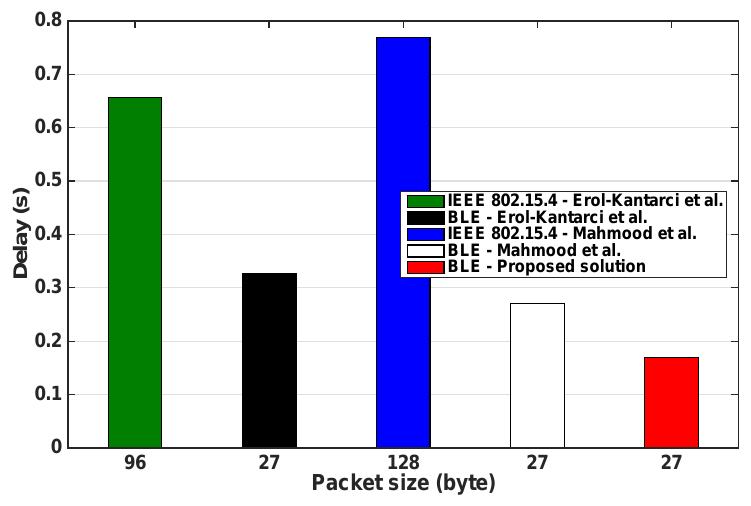
Figure 12. End-to-end delay of the WNs.